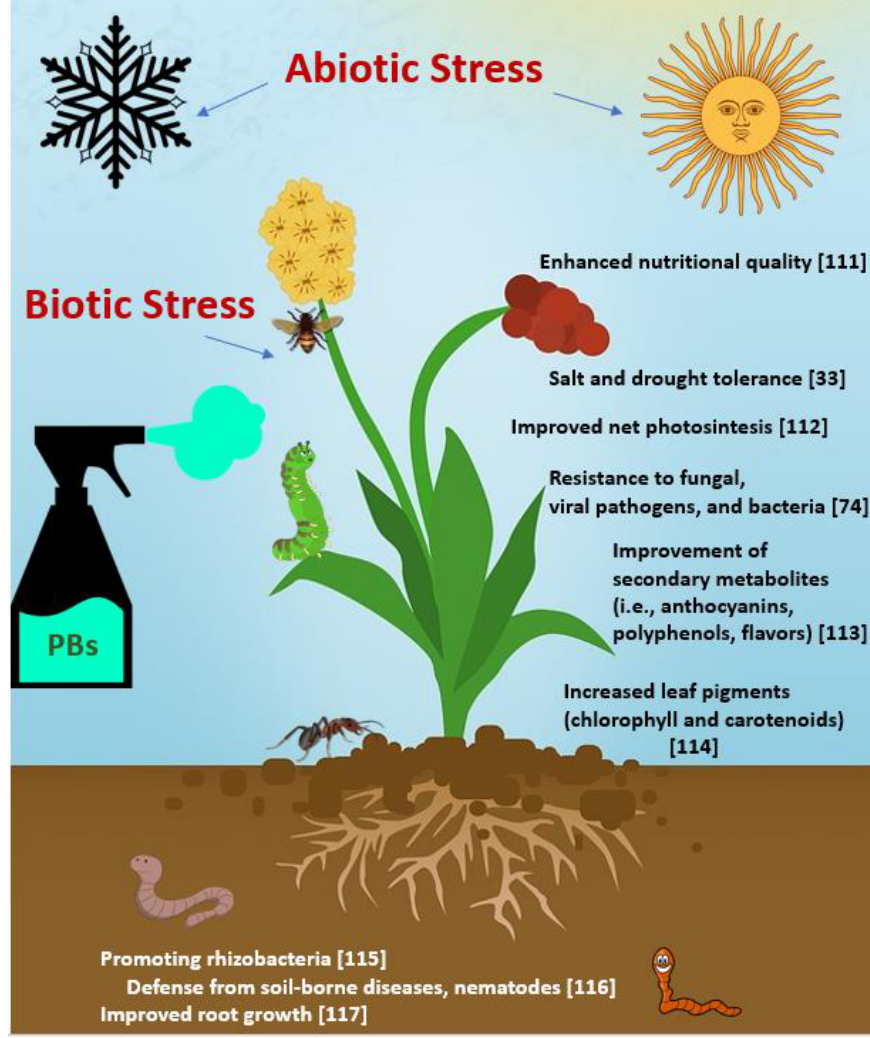
Figure 3. Main effects of biostimulants (PBs) on crops